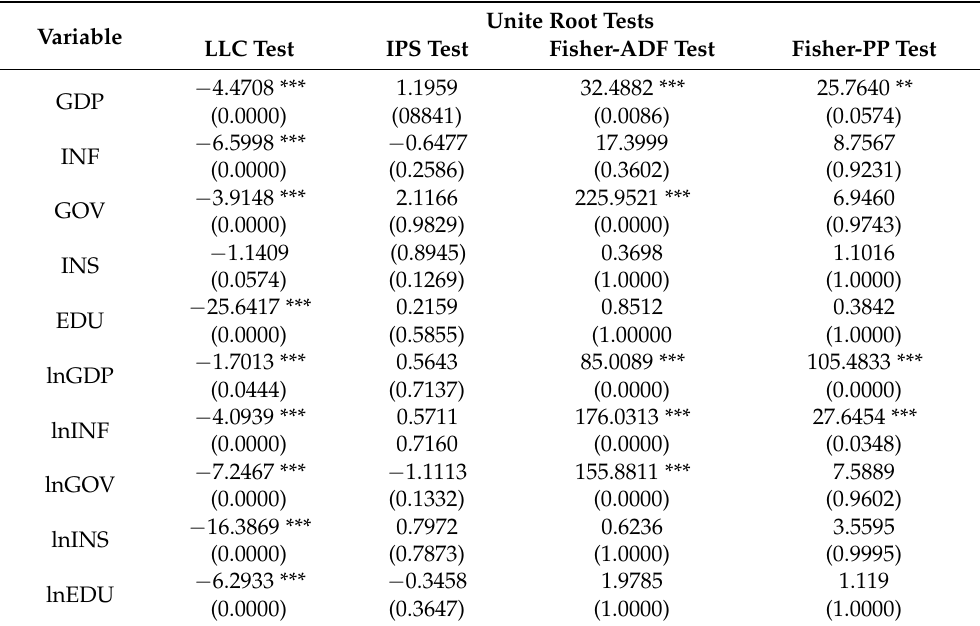
Table 4. Unit root test results.